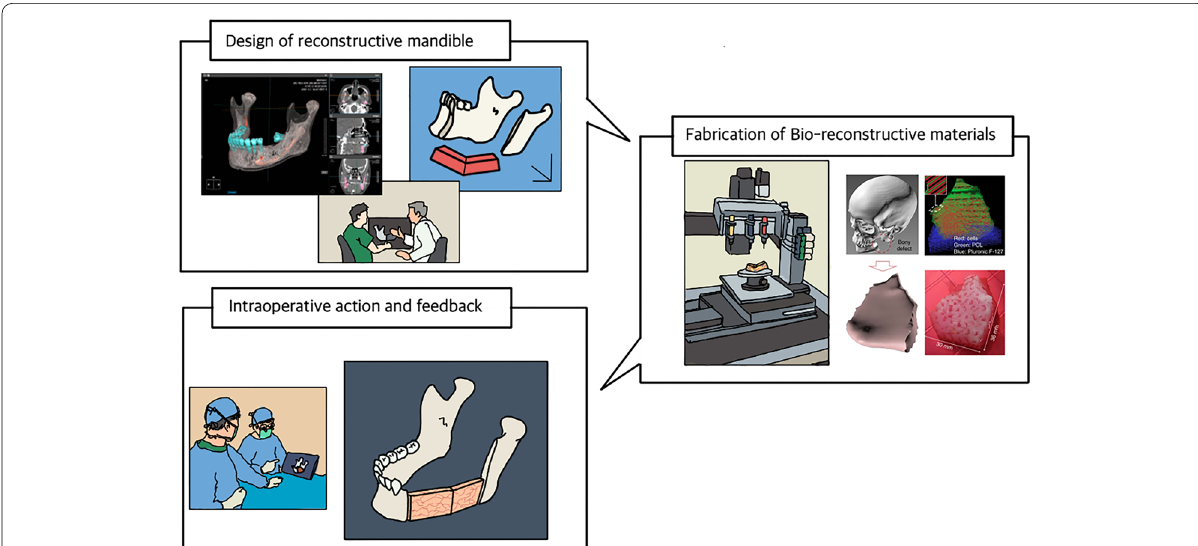
Fig. 3 On‑demand process for customized mandible reconstruction, the comprehensive on‑demand system for individual patients needed to be established, which can integrate anatomic image of individual patients, decide composition of biomaterial, design of reconstructive material, and get delivered to operation field for successful mandibular reconstruction (some part of this figure was with permission from Springer Nature. Copyright